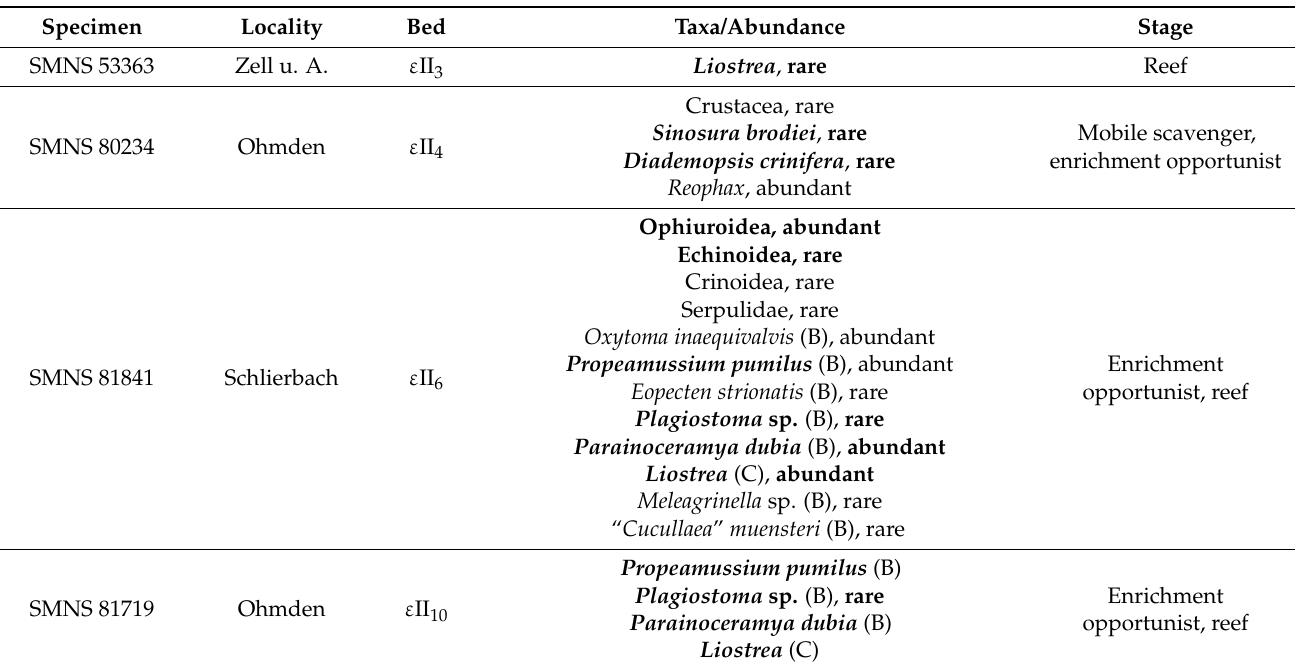
Table 2. Summary of ichthyosaur deadfalls from the Posidonienschiefer Formation associated with macroinvertebrates. Taxa in bold were recovered from more than one association. B = byssate; C =